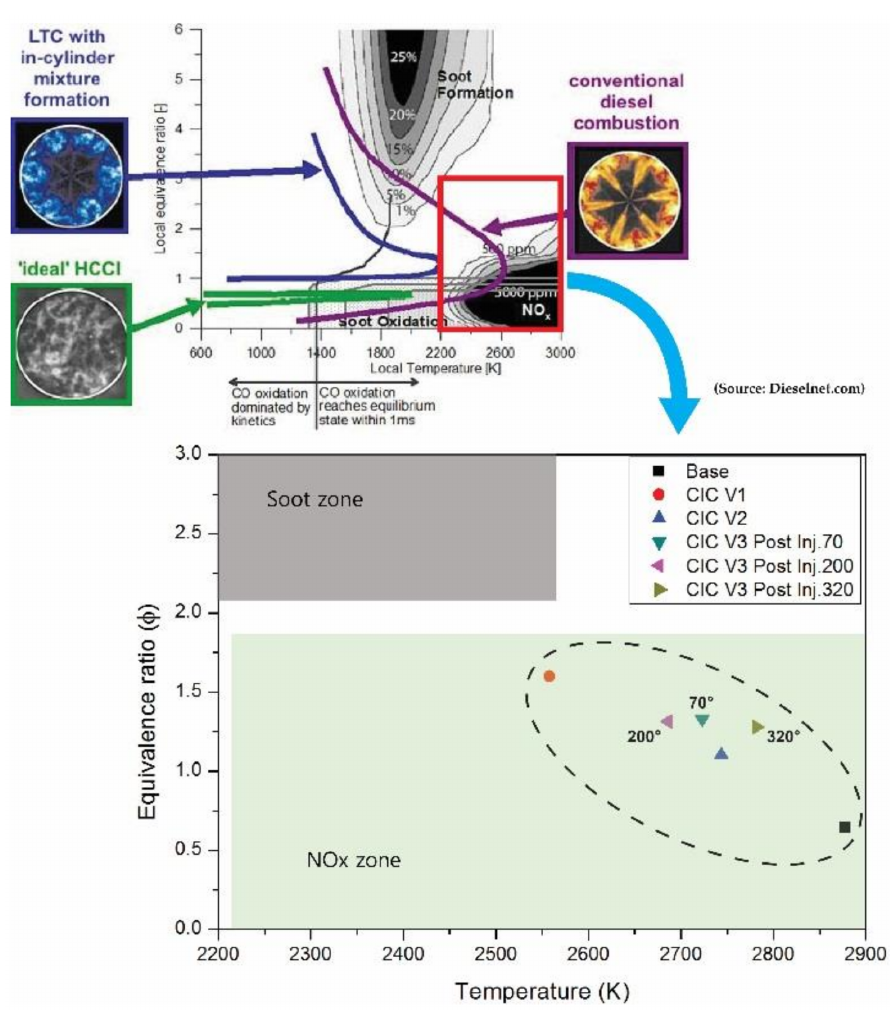
Figure 19. Comparison on NO x reduction by applying different variable valve control